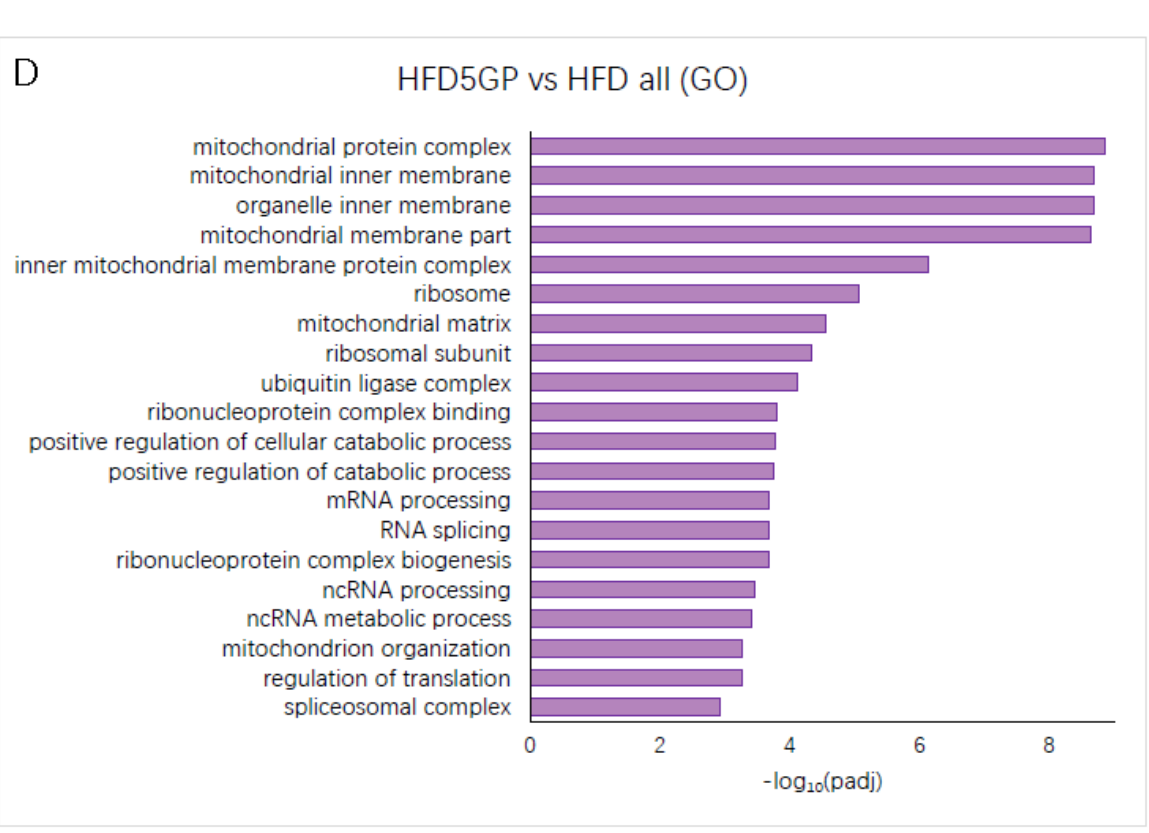
Figure 6. Grape powder supplementation of diet alters gene expression in mouse liver irrespec- tive of fat content. ( A ) Volcano plot showing upregulated (red dots) (2890), downregulated (green dots) (2107), and unaltered (blue dots) genes in the liver of mice provided with STD5GP compared with that of mice provided with STD. The threshold for differentially expressed genes was set as |log 2 (fold-change)| > 1 and − log 10 (Padj) > 1.3 (Padj < 0.05). ( B ) Volcano plot showing upregulated (red dots) (3392), downregulated (green dots) (2247), and unaltered (blue dots) genes in the liver of mice provided with HFD5GP compared with that of mice provided with HFD. The threshold for differentially expressed genes was set as |log 2 (fold-change)| > 1 and − log 10 (Padj) > 1.3 (Padj < 0.05). ( C ) GO enrichment analysis showing the top significantly enriched terms for the gene set differen- tially expressed in the liver of the STD5GPgroup compared with the STD group. ( D ) GO enrichment analysis showing the top significantly enriched terms for the gene set differentially expressed in the liver of the HFD5GP group compared to the HFD group. − log 10 (Padj) > 1.3 (Padj < 0.05) was consid- ered as statistically significant enrichment.